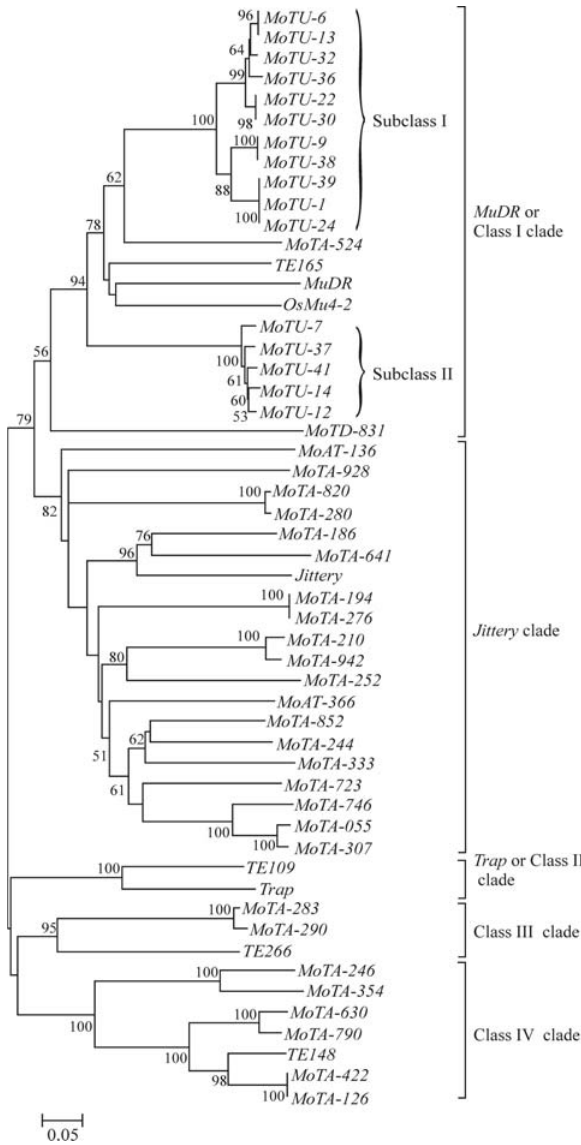
Figure 1 - Phylogenetic analysis of the nucleotide sequences of MULE transposases from Triticum and Aegilops species. Coding sequences cor- responding to amino acids 385 through 477 of the maize MURA were used for the analysis. A phylogenetic tree was constructed by the NJ method. Bootstrap values higher than 50% for 1000 replications are shown at the nodes. Classification into classes followed Rossi et al. (2004). MuDR , Jittery and Trap are from maize and OsMu4-2 (Asakura et al. 2002) is from rice. Sequences denoted with TE are from sugarcane (Rossi et al. 2004) and sequences designated MoTU were isolated from T. urartu . Details of other sequences identified in the genera Triticum and Aegilops by blastn and tblastx searches are described in Table